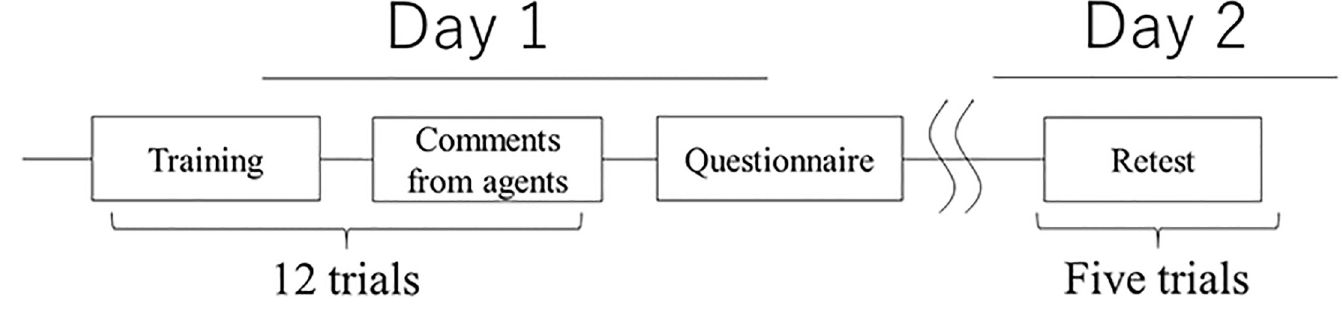
Fig 1. Experiment design of